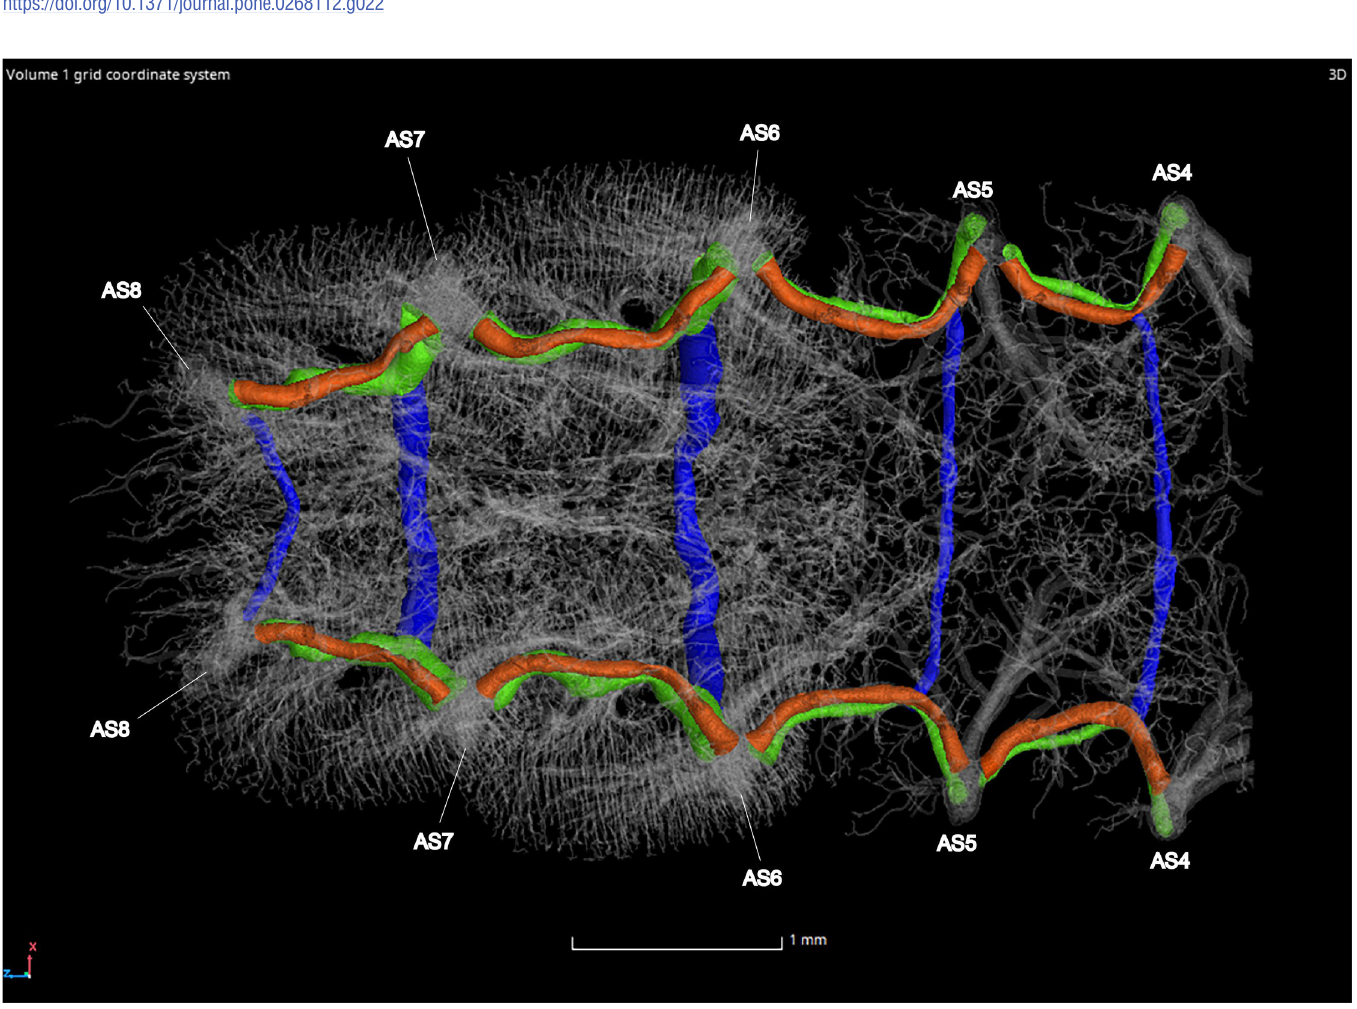
Fig 22. The spiracle of abdominal segment VIII in adult male Photinus pyralis . Internal view, ventrally (A) and dorsally (B). Abbreviations: a, atrium; l, lever; s, spiracle; SB, spiracular branch.